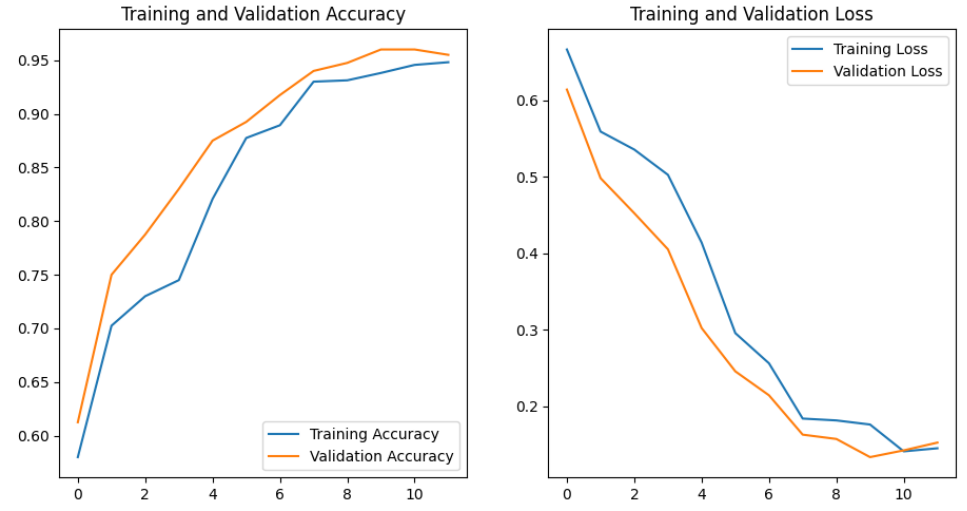
Figure 13. Values for accuracy and loss functions in the CNN training